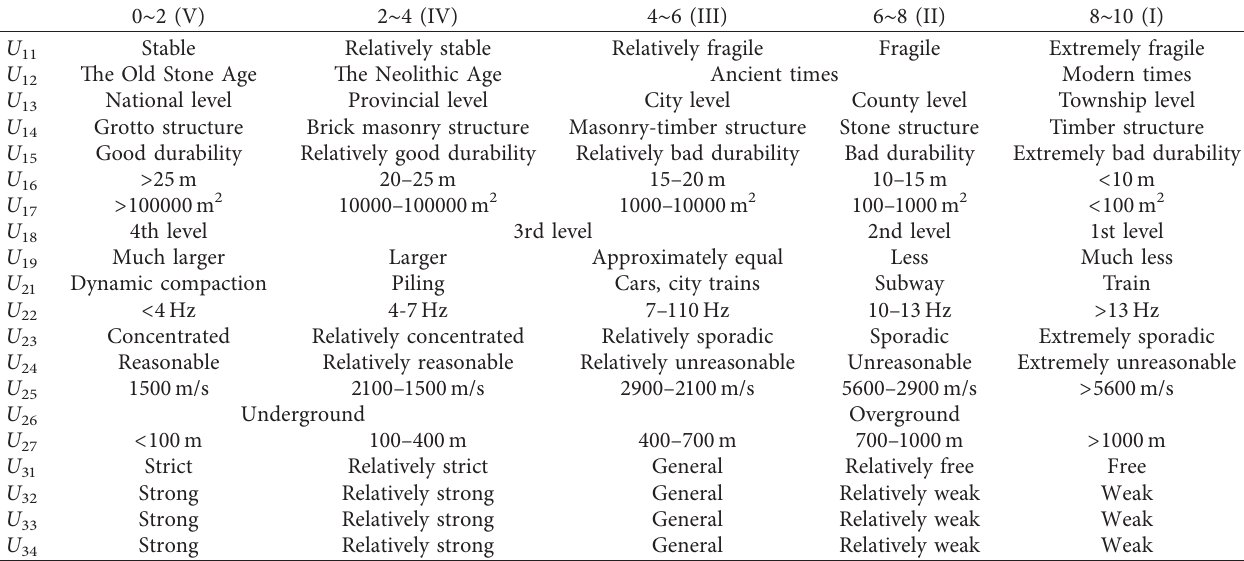
Table 2: The score criteria of the